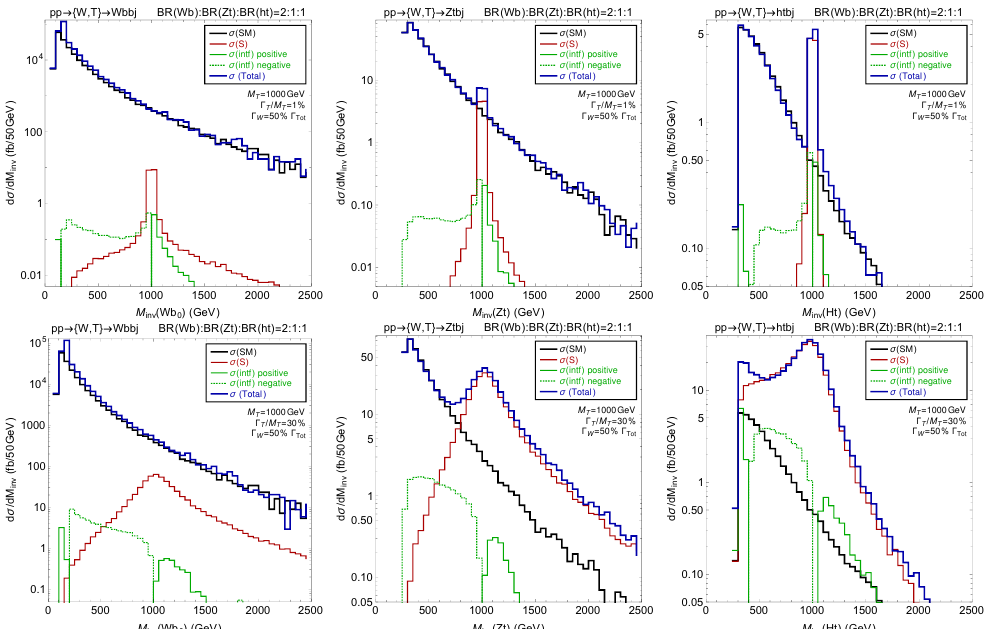
Figure 5 . Parton-level distributions in the invariant mass of the Wb (left), Zt (centre) and ht (right) systems for the pp → Wbbj , pp → Ztbj and pp → htbj processes respectively. We include the SM contribution (black), the new physics contributions stemming from a vector-like quark of mass M = 1 TeV (red) and the absolute value of their interference (green). We indicate by a T dashed line the region in which the interference is negative. We consider a narrow width scenario ( Γ = 1% , top row) and a large width one ( Γ = 30% , bottom row), and the T couplings T /M T T /M T are fixed as in eq. (3.7). For analogous results for T production through Zt exchanges, see figure 22 and